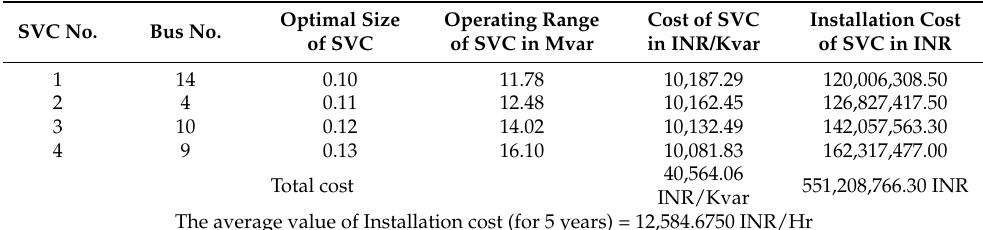
Table 4. The Optimum Size of SVC (as determined by GA) and its installation cost for the IEEE 14-bus system. SVC No. Bus No.